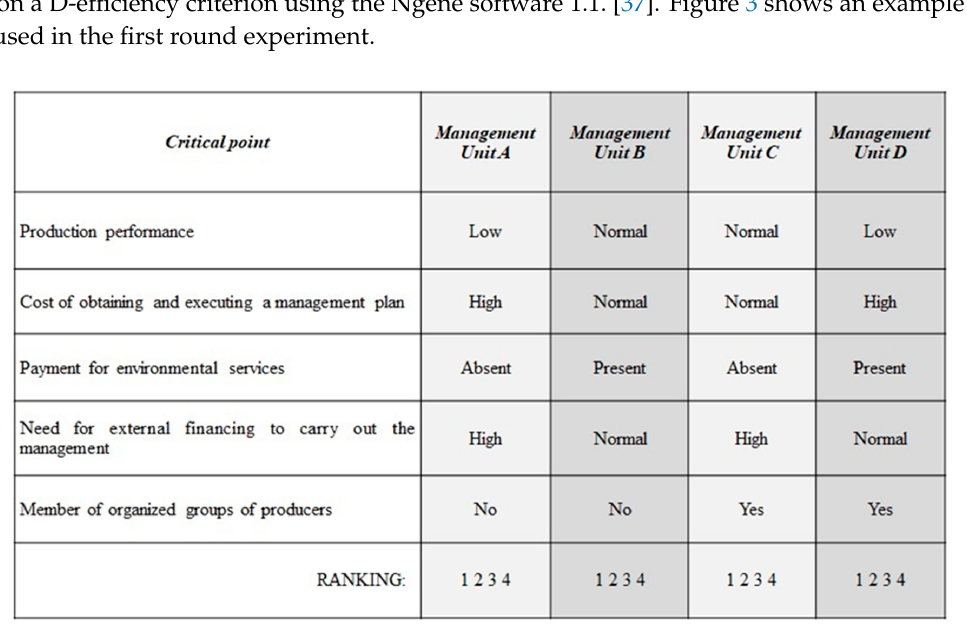
Figure 3. Example of one of the choice cards used in round I of the Delphi method. Each expert selected the order for the management units (MUs) A to D, where 1 represents the most sustainable MU and 4 the least sustainable.